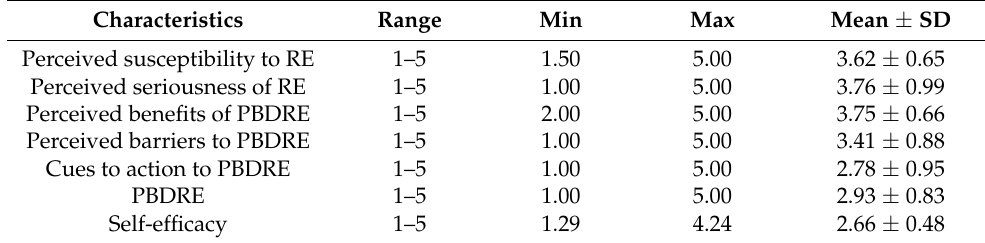
Table 2. Component distribution of health belief